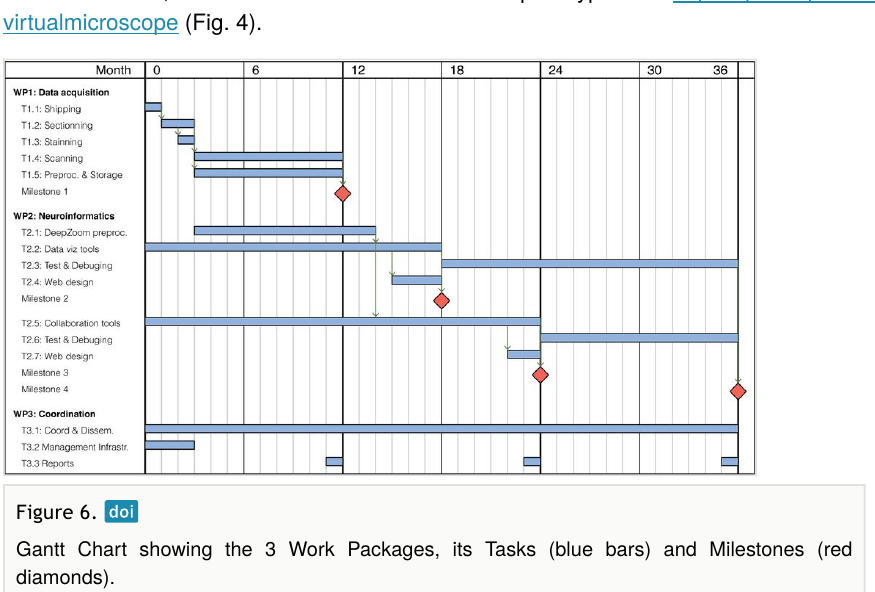
Gantt Chart showing the 3 Work Packages, its Tasks (blue bars) and Milestones (red